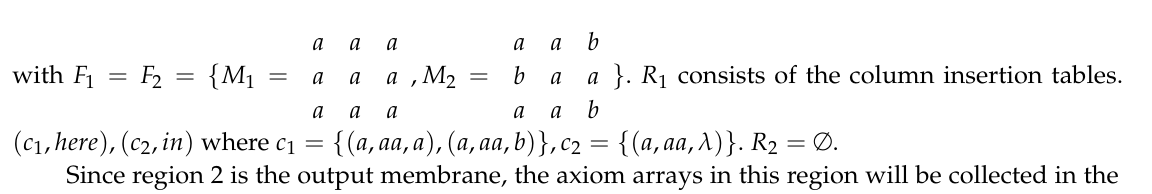
a b and while all other symbols are a . b a a b